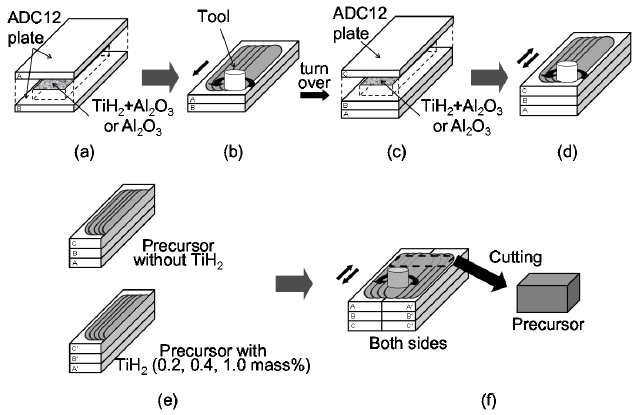
Figure 6. Schematic illustration of fabrication process used for functionally graded aluminum foam by friction stir welding (FSW) route precursor foaming method. ( a ) The powders were placed along the path of the FSW tool; ( b ) FSW was conducted; ( c ) The powders were placed along the path of the FSW tool; ( d ) FSW was conducted; ( e ) Precursors were cut; ( f ) Precursors were butt welded by FSW.